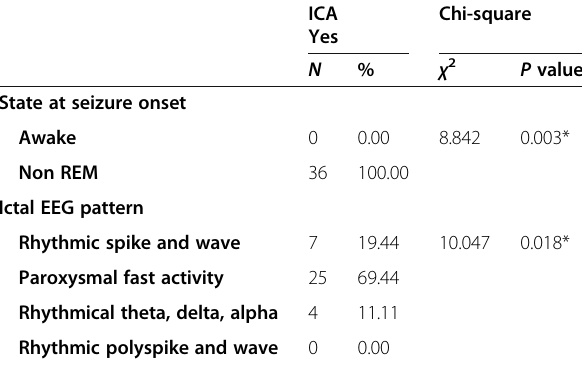
Table 2 Correlations between ICA occurrence and ictal EEG pattern and state at seizure onset